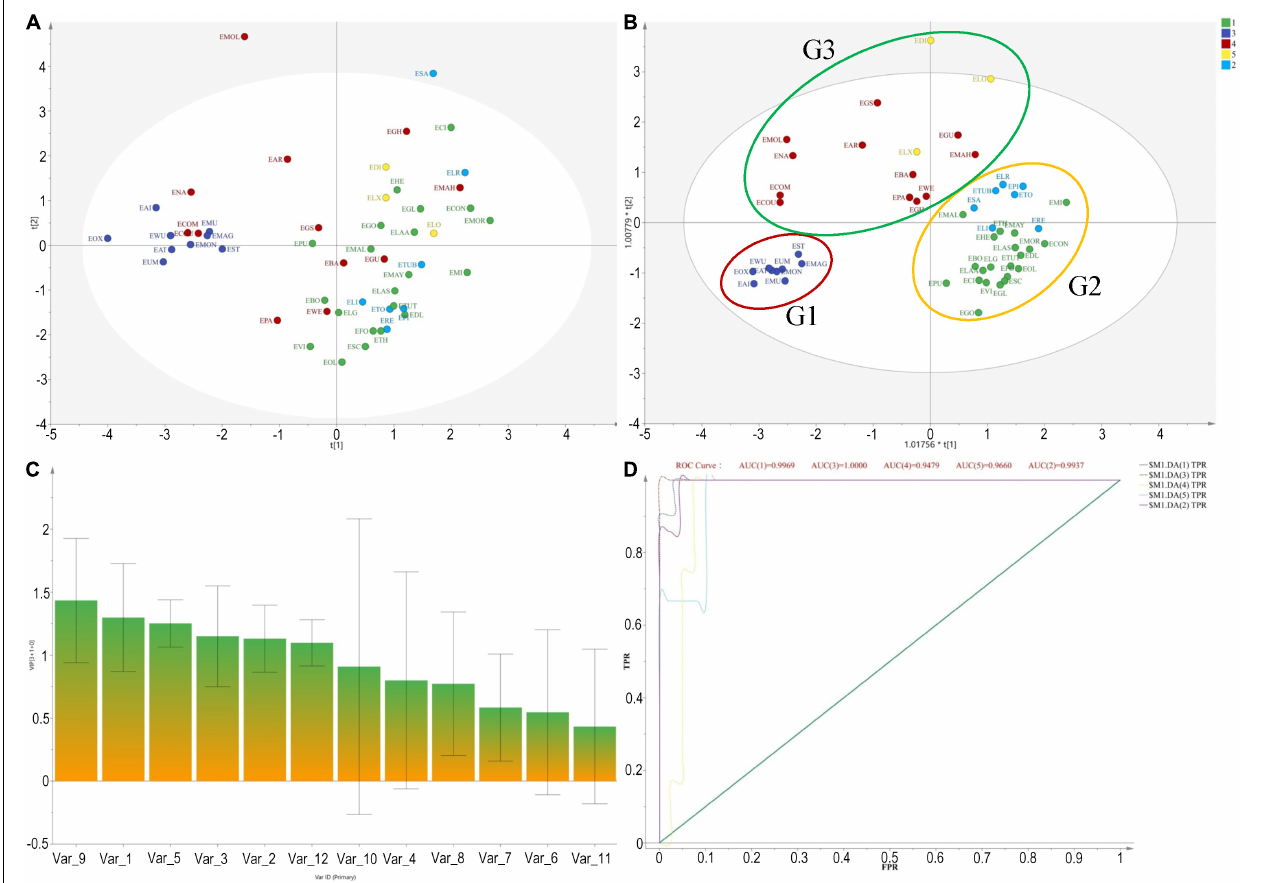
FIGURE 2 | Cluster analysis based on morphological characteristics and molecular phylogenetic tree for grouping 56 Elaeagnus species in China. (A) Pure principal component analysis performed by using morphological traits, associated with sexual plant reproduction, were extracted and quantified according to the records of the Flora of China; (B) With the orthogonal partial least squares discriminant analysis (OPLS-DA) based on the phylogenetic tree of matK sequences, 56 species were well clustered into 3 groups, which were marked with G1, G2, and G3; (C) The variable importance for the projection (VIP) summarizing the importance of the variables, and this plot is sorted to display larger VIPs to the left. The top 5 contributing quantitative traits affecting the current clustering model are V9 (flower color), V1 (flowering), V5 (evergreen or deciduous), V3 (leaf size), and V2 (fruiting), respectively, (VIP > 1); and (D) The receiver operating characteristic (ROC) curve was used to evaluate the effectiveness of the grouping